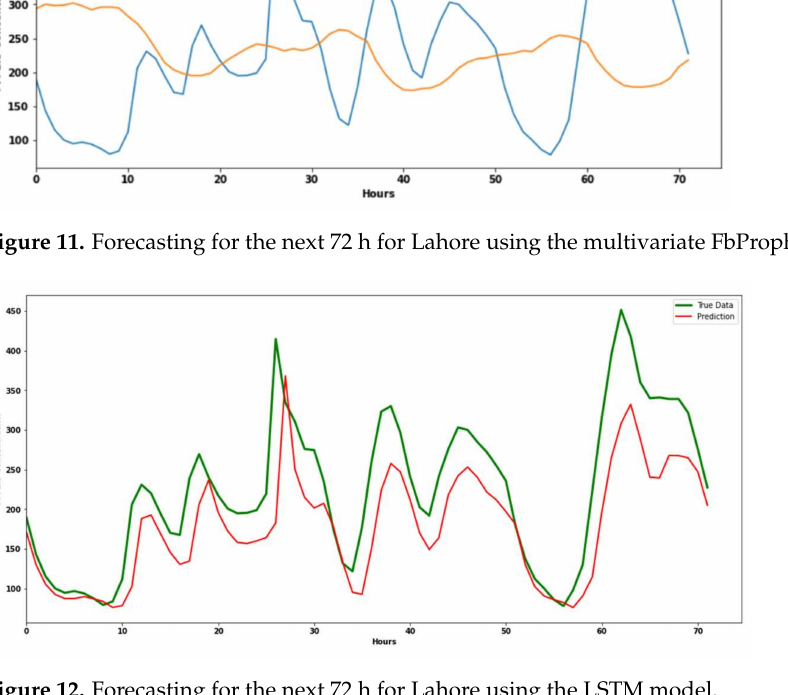
Figure 12. Forecasting for the next 72 h for Lahore using the LSTM